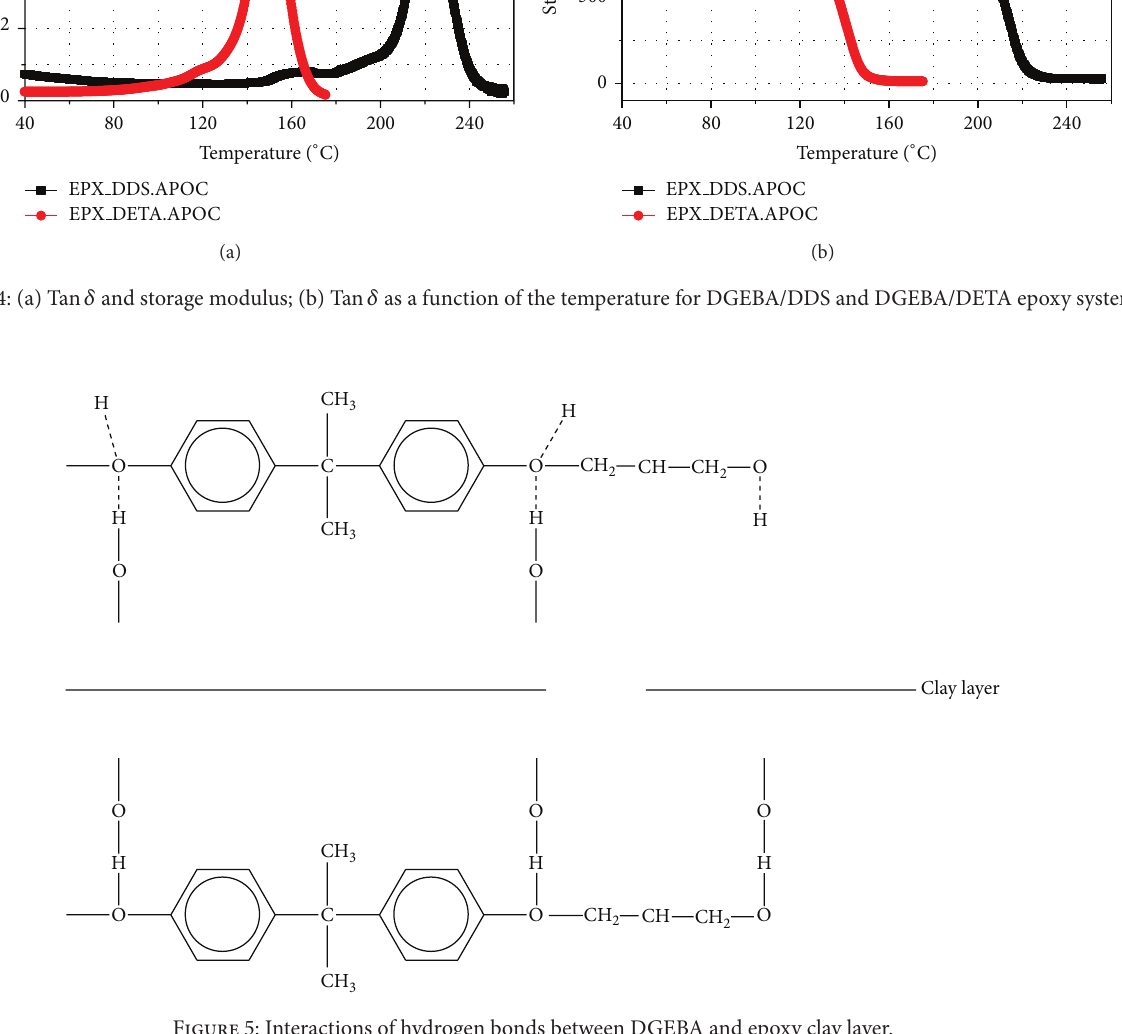
Figure 5: Interactions of hydrogen bonds between DGEBA and epoxy clay layer.